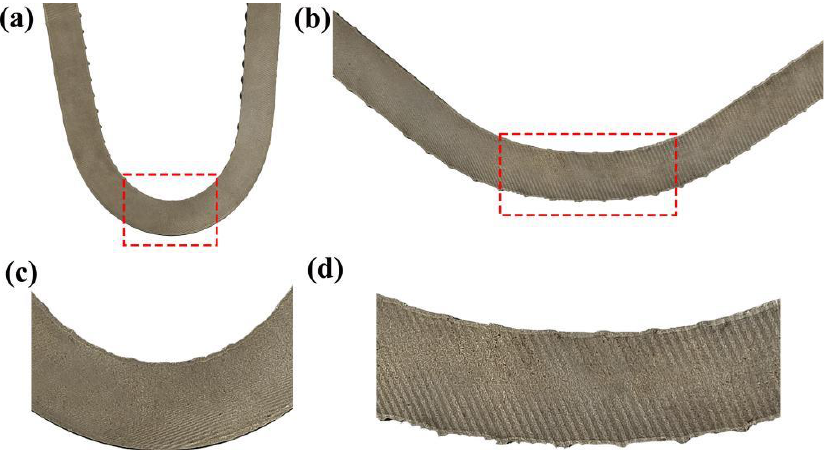
Figure 11. Schematics of the rebar bending profile: ( a ) positive bending, ( b ) reverse bending, ( c ) partial enlarged view of positive bending, and ( d ) partial enlarged view of reverse bending.